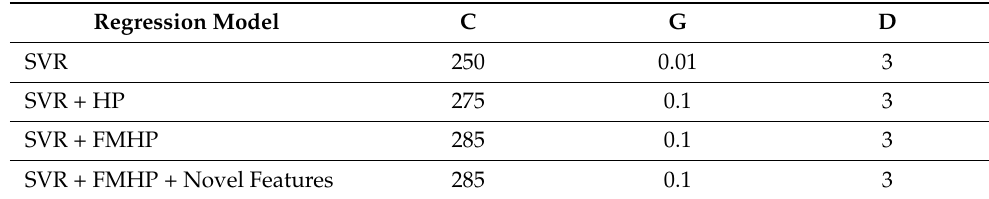
Table 2. Kernel parameter settings.